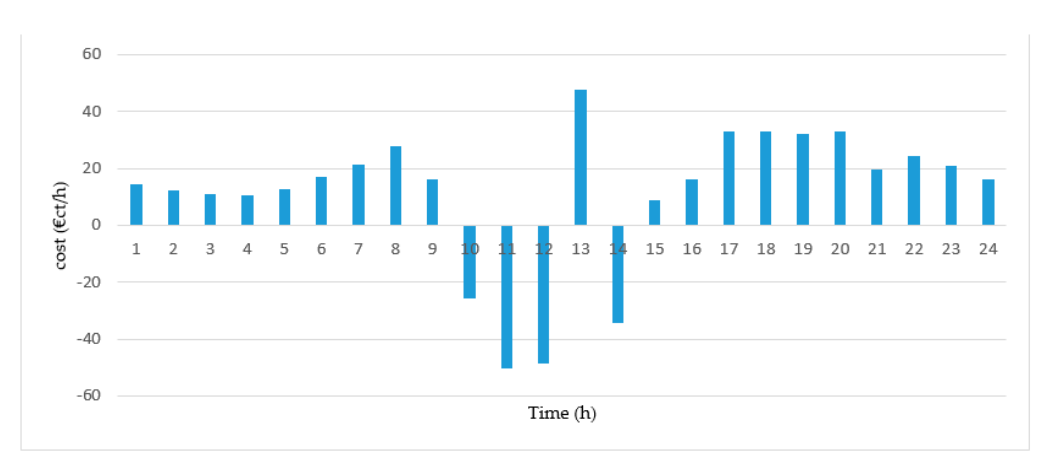
Figure 13. The optimal operation cost of the first scenario for each hour a day.